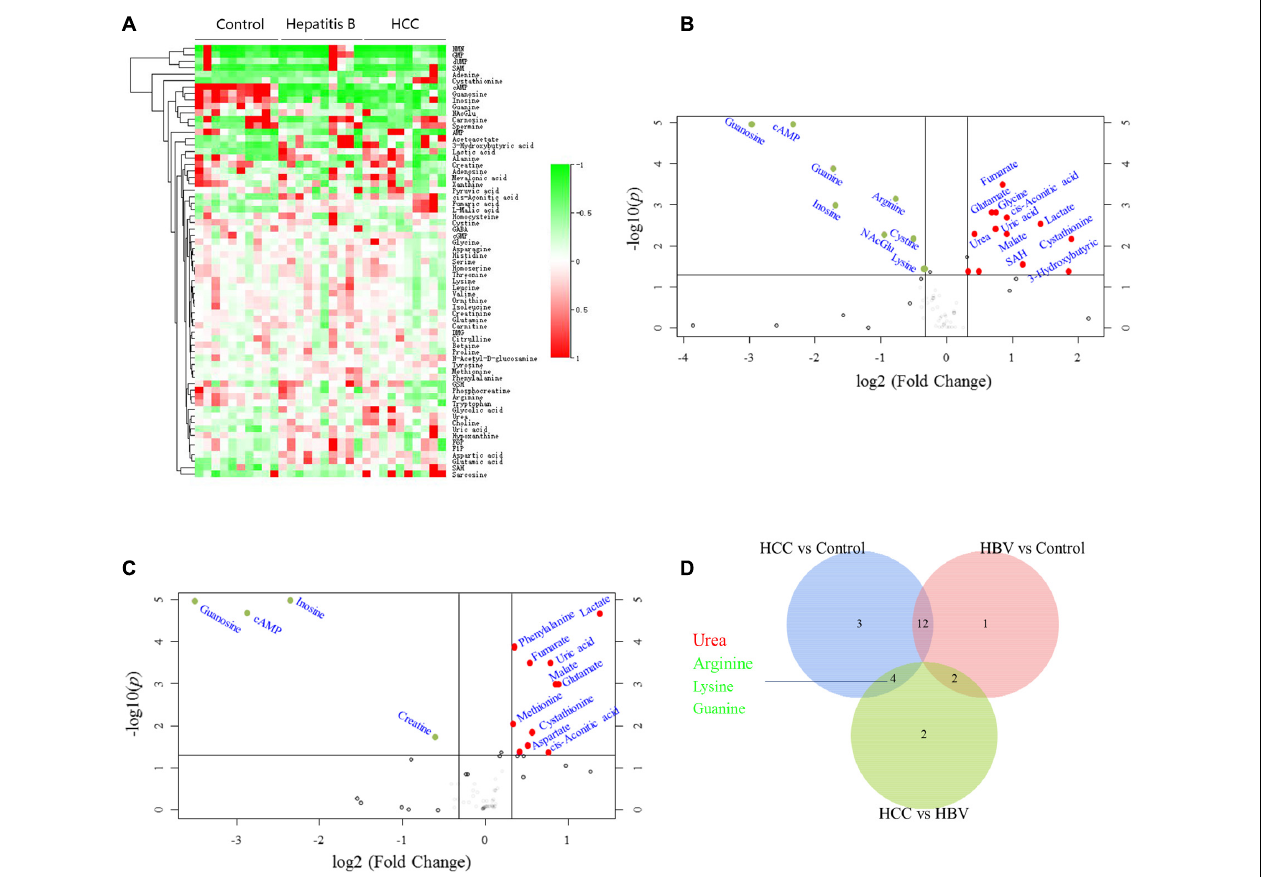
FIGURE 1 | Screening for differential serum metabolites of HCC by targeted metabolomics. (A) Heatmap clustering analysis of differential metabolites in serum of 10 normal controls, 10 HBV and 10 HBV positive HCC patients. (B) Metabolites volcano map of HCC vs control. Compared with the control group, the significantly increased metabolites were shown in red, and the significantly decreased metabolites were shown in green. (C) Metabolites volcano map of HBV vs control. Compared with the control group, the significantly increased metabolites were shown in red, and the significantly decreased metabolites were shown in green. (D) Venn diagram was used to characterize different metabolites of HCC vs control, HBV vs control and HCC vs